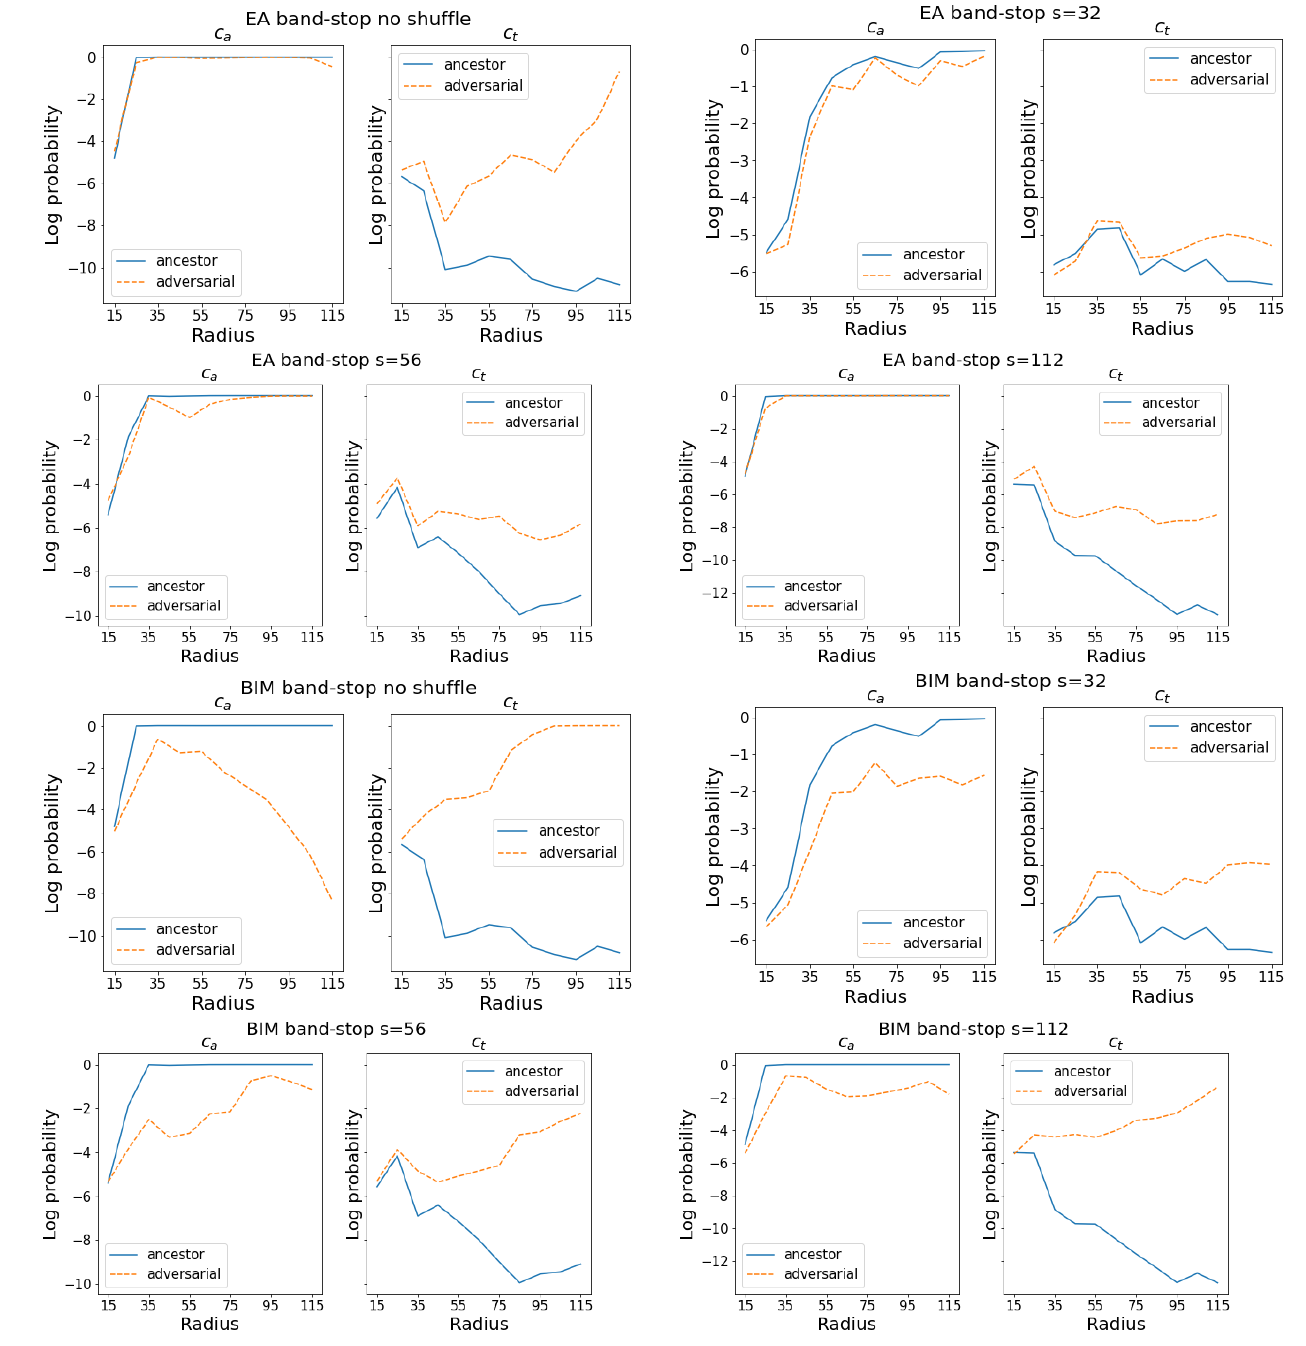
Figure 5. For atk = EA (first and second rows) and atk = BIM (third and fourth rows), the fol- ( A 4 ) (first pair), sh ( A 4 ( A 4 ) ,32 ) (second lowing images are fed to C 6 : A 4 and D atk ,32 ) and sh ( D atk 5 5 5 5 6 6 ( A 4 ) ,56 ) (third pair), and sh ( A 4 ( A 4 ) ,112 ) (third pair). pair), sh ( A 4 ,56 ) and sh ( D atk ,112 ) and sh ( D atk 5 5 5 5 6 6 In each pair of graphs, the left graph displays the c a -label values given by C 6 as the images are band-stop filtered with bandwidths centred on different rc values, and the right graph displays the c t -label values, mutatis mutandis